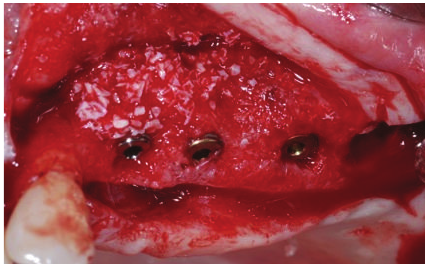
Figure 9: At the time of dental implants the healed bone has been removed and analyzed in order to perform the histologic analysis.